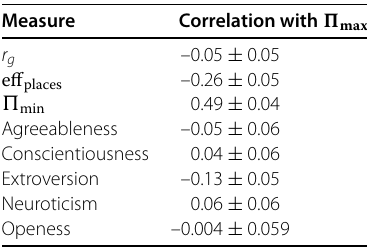
Table 1 Examining which factors impact the predictability of human mobility patterns. r g is the radius of gyration, eff places is the effective number of places an individual chooses from when changing to a new location and is defined as 2 H unc . We also examine the impact of basic personality traits using the Big Five psychological profile [30]. Error bars are determined using the bootstrap